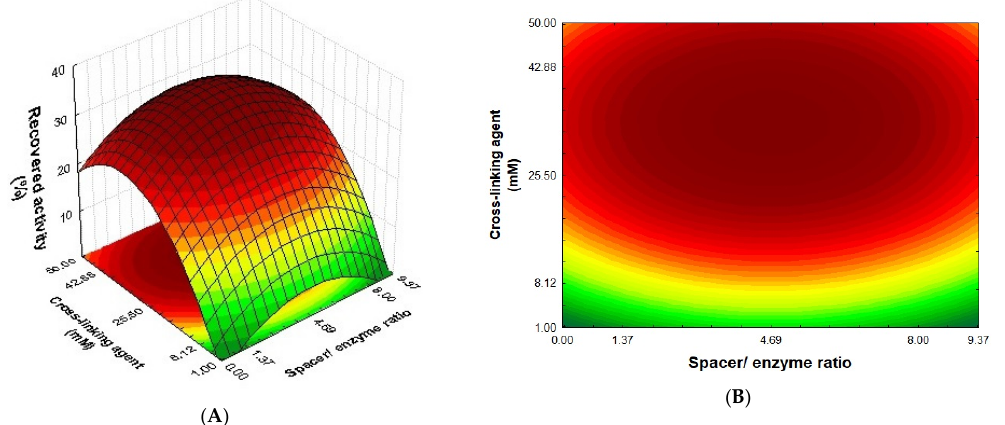
Figure 1. β -glucosidase recovered activity as a function of cross-linking agent (glutaraldehyde) and spacer/enzyme ratio after 60 min of reaction time: ( A ) response surface and ( B ) contour curve.